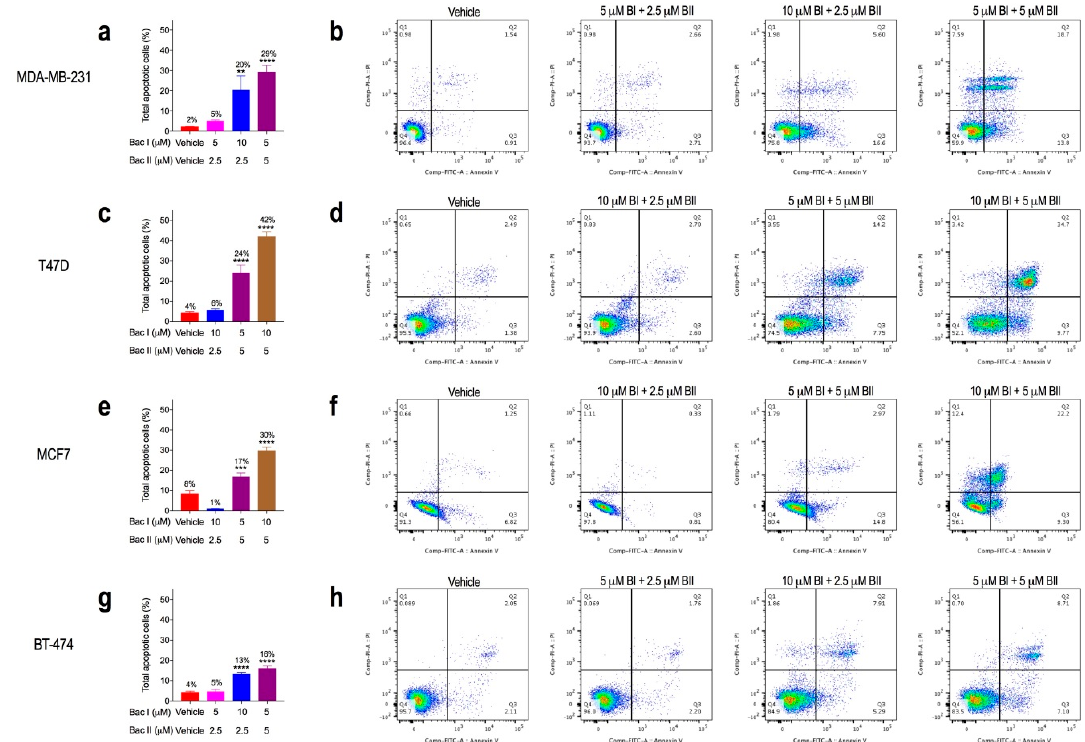
Figure 4. Higher-dose combinations of bac I and II induced apoptosis in breast cancer cell lines. Graphs ( a , c , e , g ) show the effect of the vehicle or bac I and bac II combined on the percentage of total apoptotic cells (early and late), with the representative scatterplots ( b , d , f , h ) showing the population gates of viable cells (left lower quadrant) or cells in early apoptosis (right lower quadrant), late apoptosis (right upper quadrant), or necrosis (left upper quadrant). Results for MDA-MB-231 ( a , b ), T47D ( c , d ), MCF7 ( e , f ) and BT-474 ( g , h ) are the mean ± SD of apoptotic cells from a representative experiment (n = 3). p -values, relative to vehicle, were determined by one-way ANOVA with Bonferroni test (** p = 0.001; *** p = 0.0003; **** p < 0.0001).